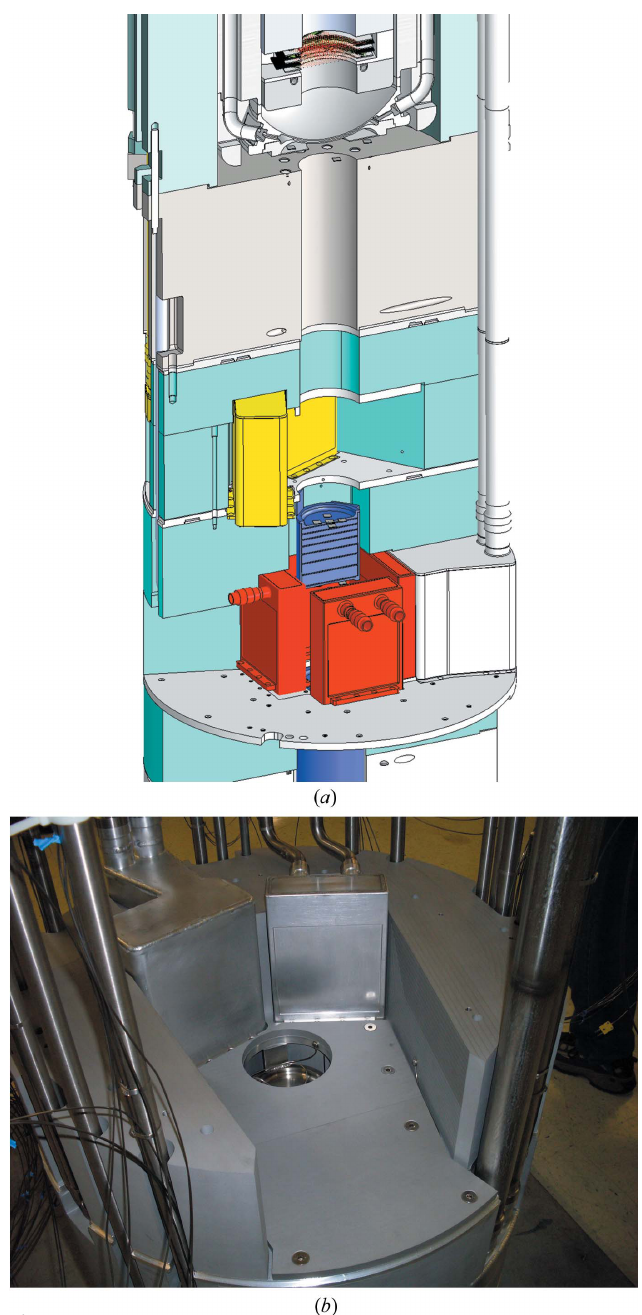
Figure 5 ( a ) Schematic of the Mark-III TMRS. Beryllium reflectors are in cyan, tungsten target plates in blue and moderator suites in yellow and red. The proton beam strikes the target from above. ( b ) Upper moderator suite, with the H 2 O moderator for FP14 and FP15 at the center, a H 2 moderator to its left and beryllium reflectors arranged around the moderator. The neutrons for FP15 are directed towards the foreground.